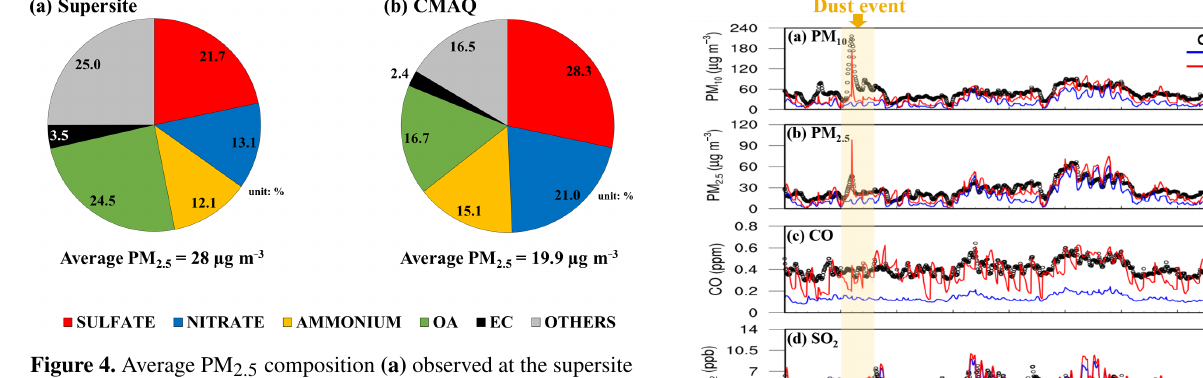
Figure 4. Average PM 2 . 5 composition (a) observed at the supersite stations and (b) simulated by the CMAQ model during the KORUS- AQ campaign. The averaged PM 2 . 5 measured from the supersites and calculated from the CMAQ model simulations over the period of the KORUS-AQ campaign are 28 and 19.9µgm − 3 , respectively. The mass of organic aerosols (OAs) was calculated by multiplying organic carbon mass by 1.6.